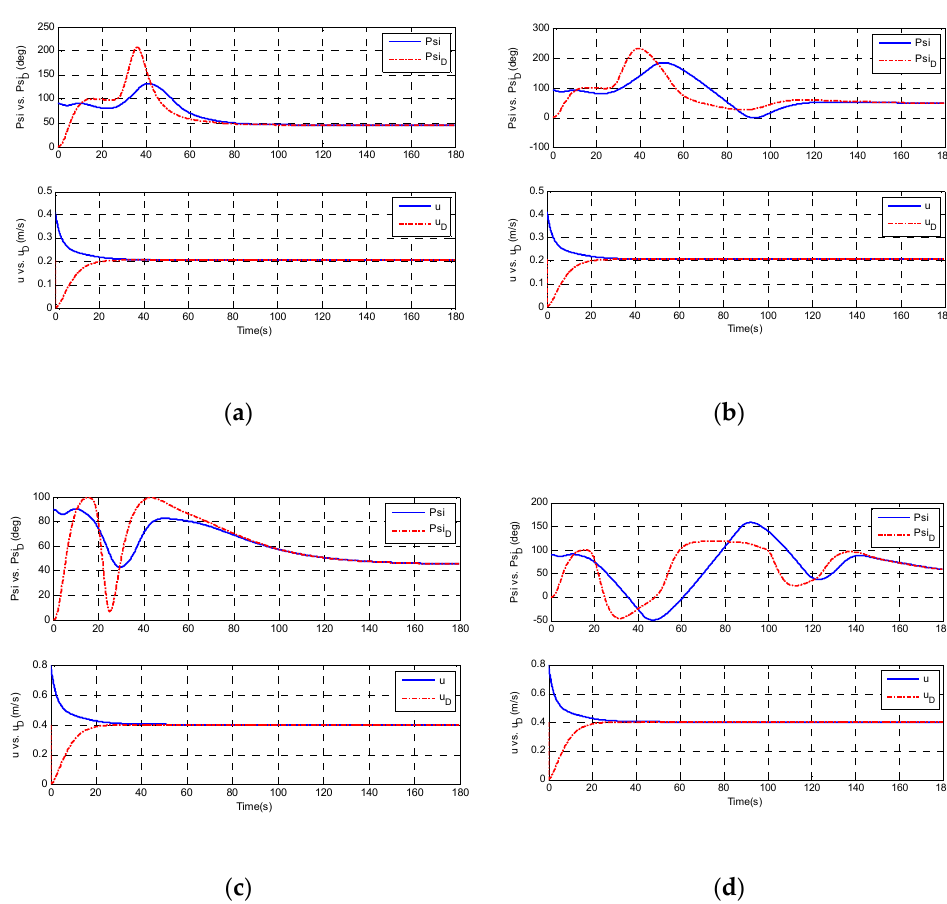
Figure 11. Heading angle, surge speed (desired versus true) from the simulations: ( a ) round obstacle with collision risk; ( b ) round obstacle without collision risk; ( c ) rectangular obstacle with collision risk; and ( d ) rectangular obstacle without collision risk.